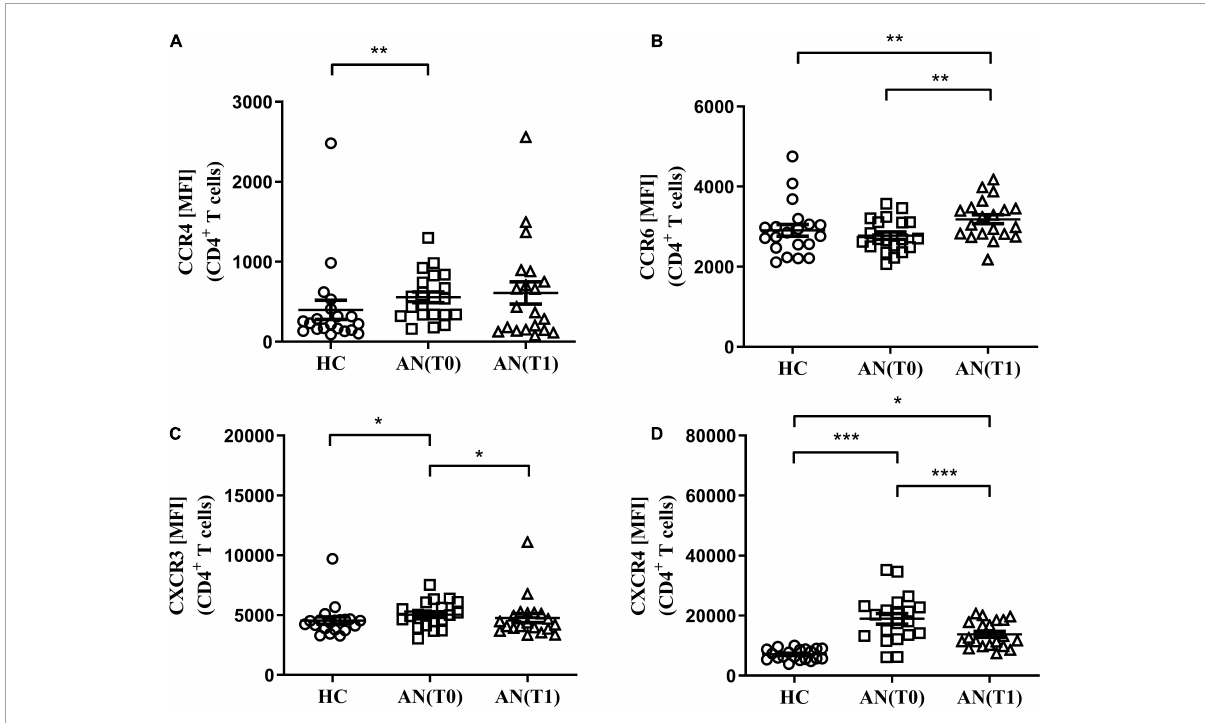
FIGURE1 Mean fluorescence intensity (MFI) of chemokine receptors on CD4 + T cells. (A) CCR4, (B) CCR6, (C) CXCR3, and (D) CXCR4 MFI on CD4 + T cells in healthy controls (HC: n = 20), adolescents with anorexia nervosa (AN) at admission (T0, n = 20) and after 6 weeks of therapy (T1, n = 20), * p < 0.05; ** p < 0.01; and *** p < 0.001.